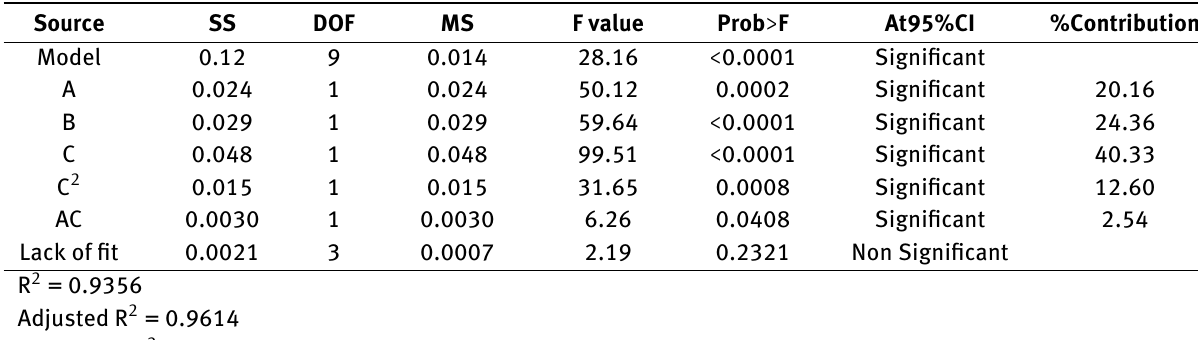
Figure 7: Main effect Plots for Overcut (a) Ton Vs OC; (b) Toff Vs OC; (c) Ip Vs OC Table 6: ANOVA for response surface quadratic model for